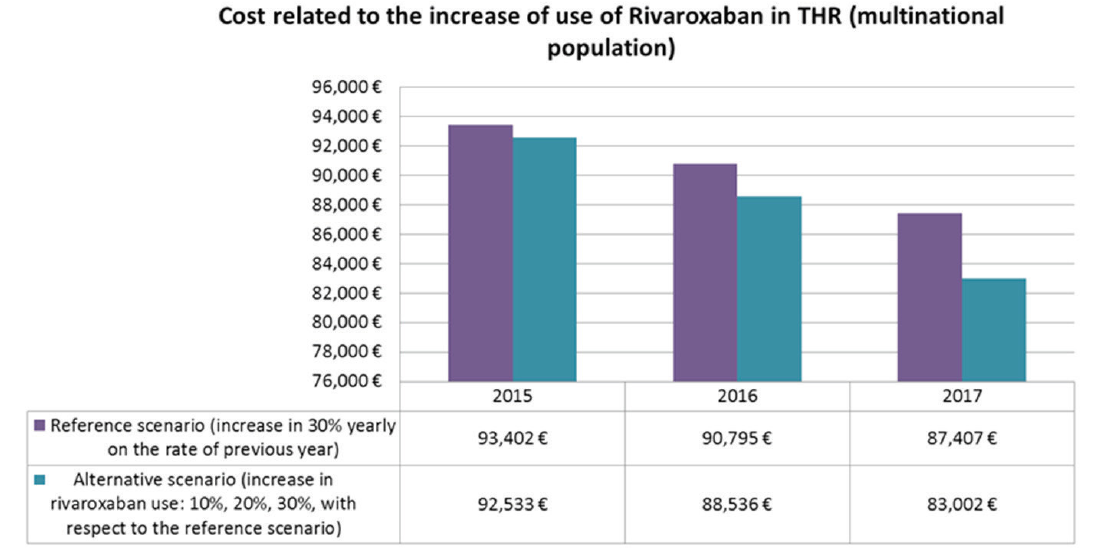
Figure 2. THR Cohort Costs 2015-2017, Multinational Population; THR Cohort Total Costs 2015-2017 in the Base-case and alternative Scenarios in Spain estimated on the Basis of Event Rates from the Multinational Population of the XAMOS